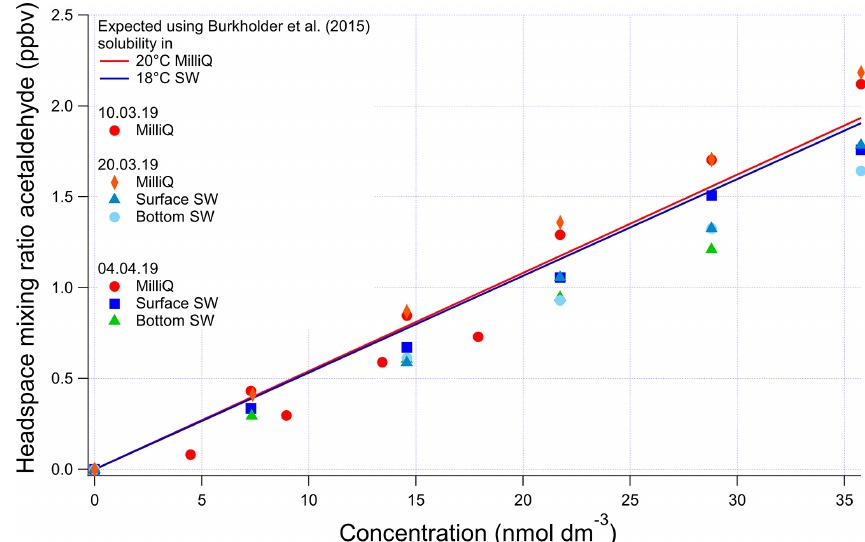
Figure A4. Evasion calibrations using liquid standards of acetaldehyde produced by serial dilution in different types of water (SW: sea- water; MilliQ: Milli-Q water). Bottom SW refers to seawater collected from well below the mixed layer. Surface SW refers to sea- water collected from the ship’s underway seawater inlet. The average measured slope in the four seawater calibrations is 0 . 0473 ± 0 . 00313ppbv(nmoldm − 3 ) − 1 (6%rel.SD), and the average slope in the four Milli-Q calibrations is 0 . 0548 ± 0 . 00767ppbv(nmoldm − 3 ) − 1 (14%rel.SD). Expected mixing ratios are slightly different between Milli-Q and SW due to the lower seawater